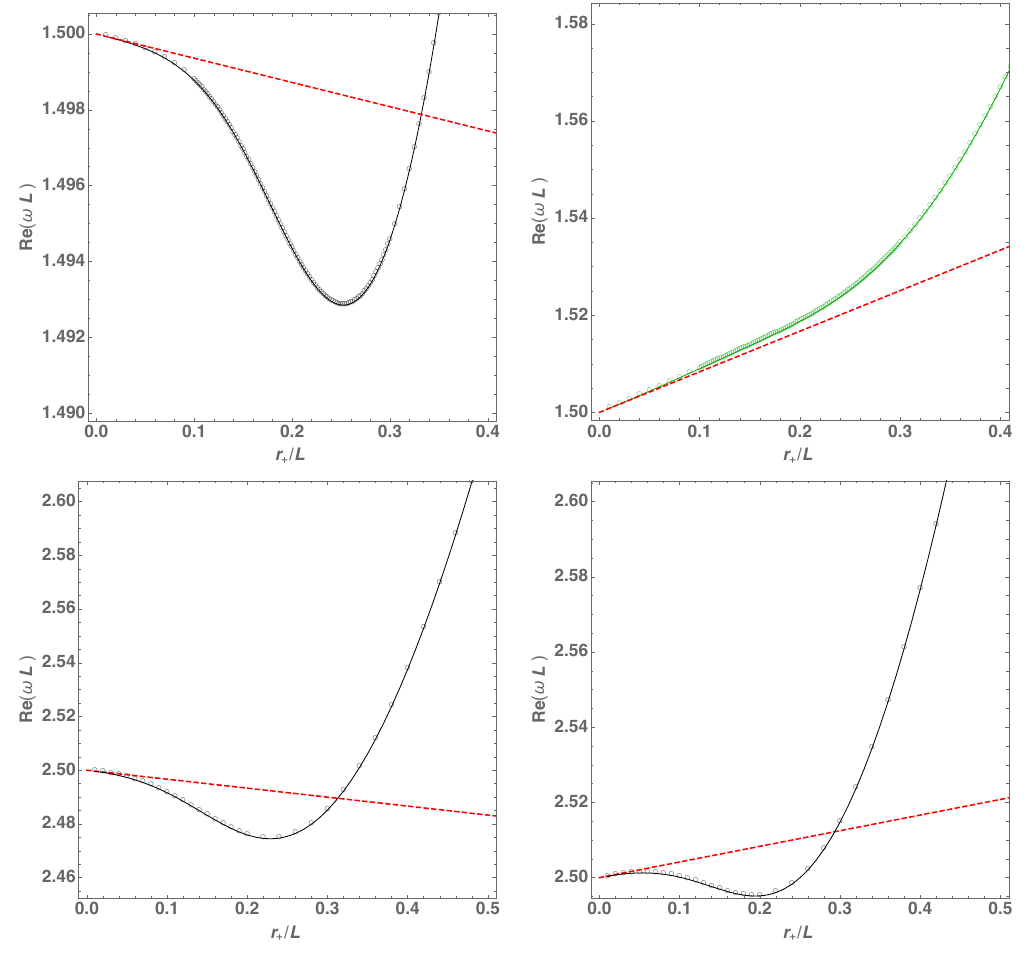
Figure 12 . Real part of the frequencies as a function of the horizon radius. Top panel : Alternative quantization (2.44) and (cid:12)xed chemical potential (cid:22) = (cid:22) ext (1 (cid:0) 10 (cid:0) 2 ) and charges qL = 0 : 7 (left panel) and qL = 0 : 8 (right panel). The red dashed line describes the perturbative result (C.4). Bottom : Standard quantization (2.43) and (cid:12)xed chemical potential (cid:22) = (cid:22) ext (left panel) and qL = 2 (right panel). The red dashed line describes the perturbative result